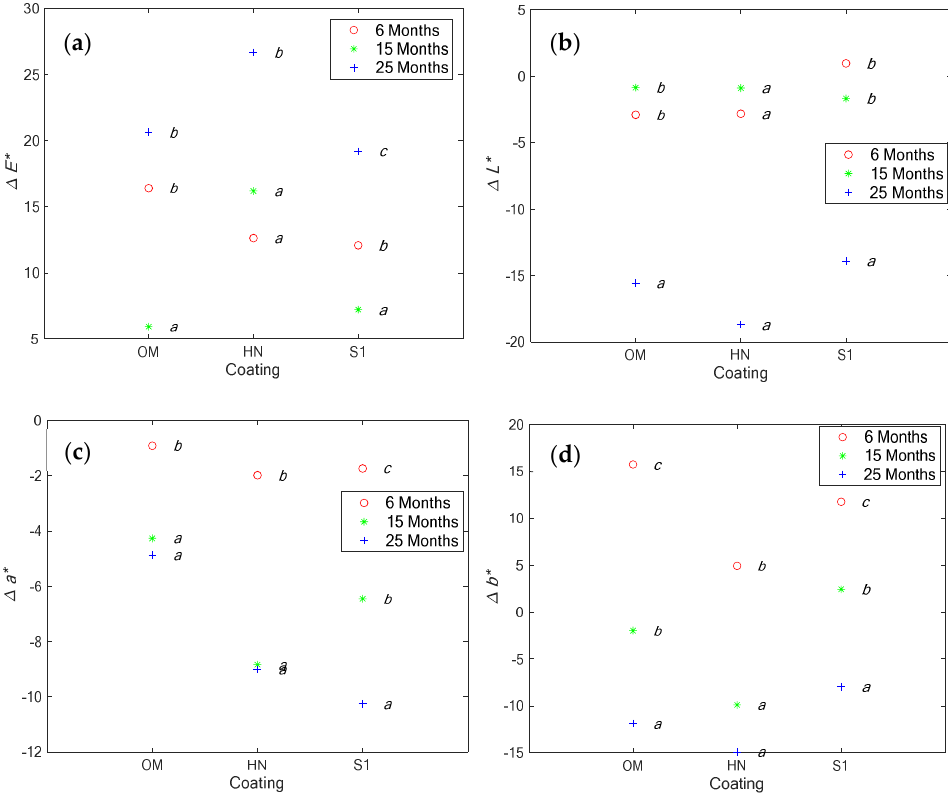
Figure 4. Games–Howell pairwise mean differences in ∆ E , ∆ L* , ∆ a*, and ∆ b* for three coatings on Douglas fir samples exposed outdoors for 24 months. Superscripts with the same letter indicate that means between intervals do not differ significantly at p < 0.05. ( a ) color change ( ∆ E) , ( b ) ∆ L* , ( c ) ∆ a* , ( d ) ∆ b*